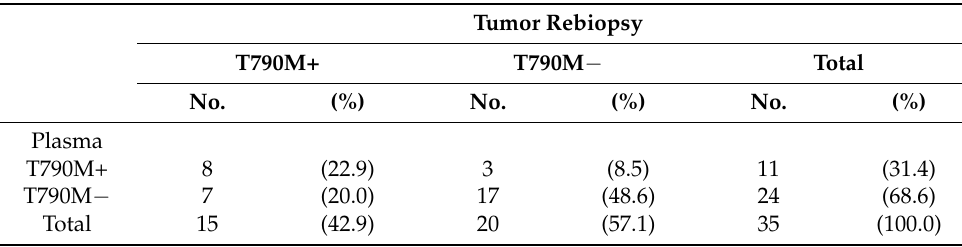
Table 5. Comparison of EGFR T790M mutation status determined from the plasma and tumor rebiopsy samples at disease progression (N = 35).